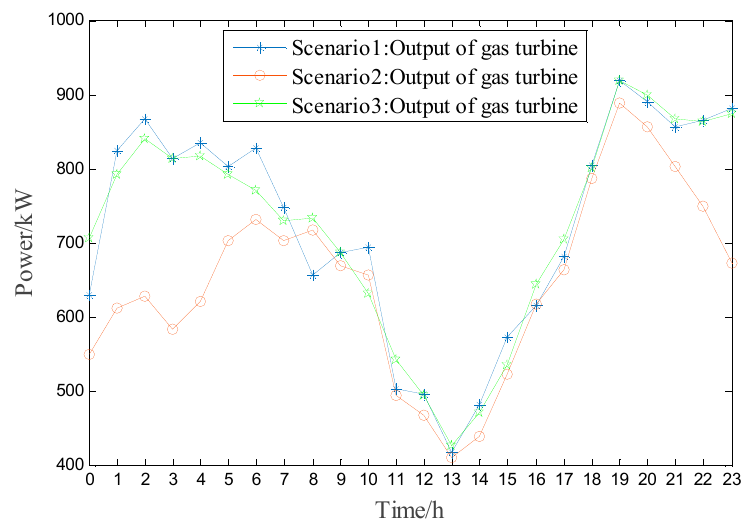
Figure 13. Output thermal energy of gas turbine in different scenarios.